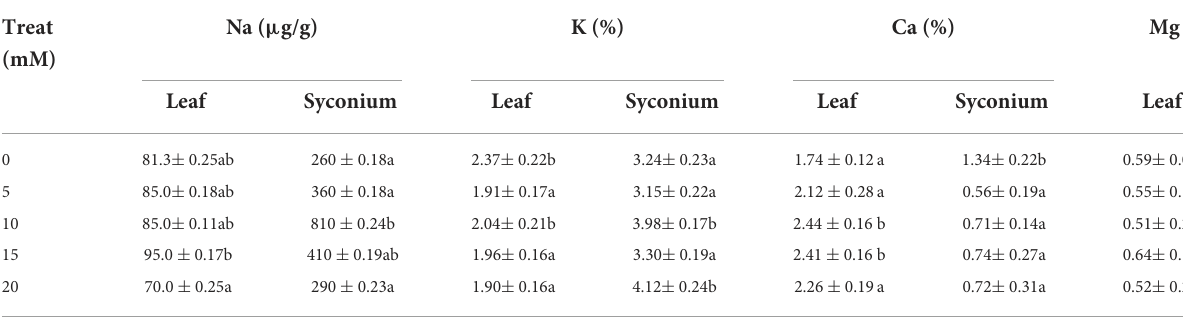
TABLE 4 The effects of H 2 O 2 on macro mineral uptake and accumulation of F. deltoidea plants under drought stressed